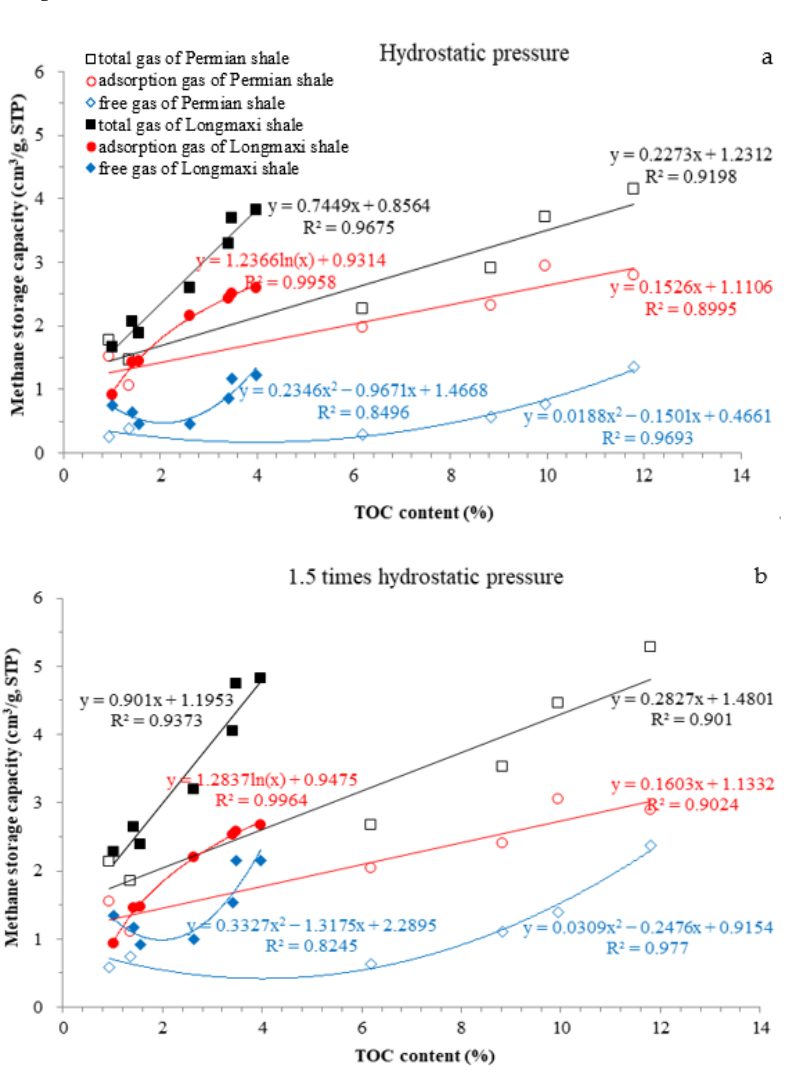
Figure 13. Plots showing the relationships of the TOC content and the MSC of the Permian and Lower Silurian shales [8] under hydrostatic pressure ( a ) and 1.5 times hydrostatic pressure ( b ). The set reservoir temperature is 60 °C, corresponding buried depth of approximately 2000 m. The water saturation is 30% for the reservoir with hydrostatic pressure, and 20% for the reservoir with 1.5 times hydrostatic pressure. (All drawings have the same icons shown in the